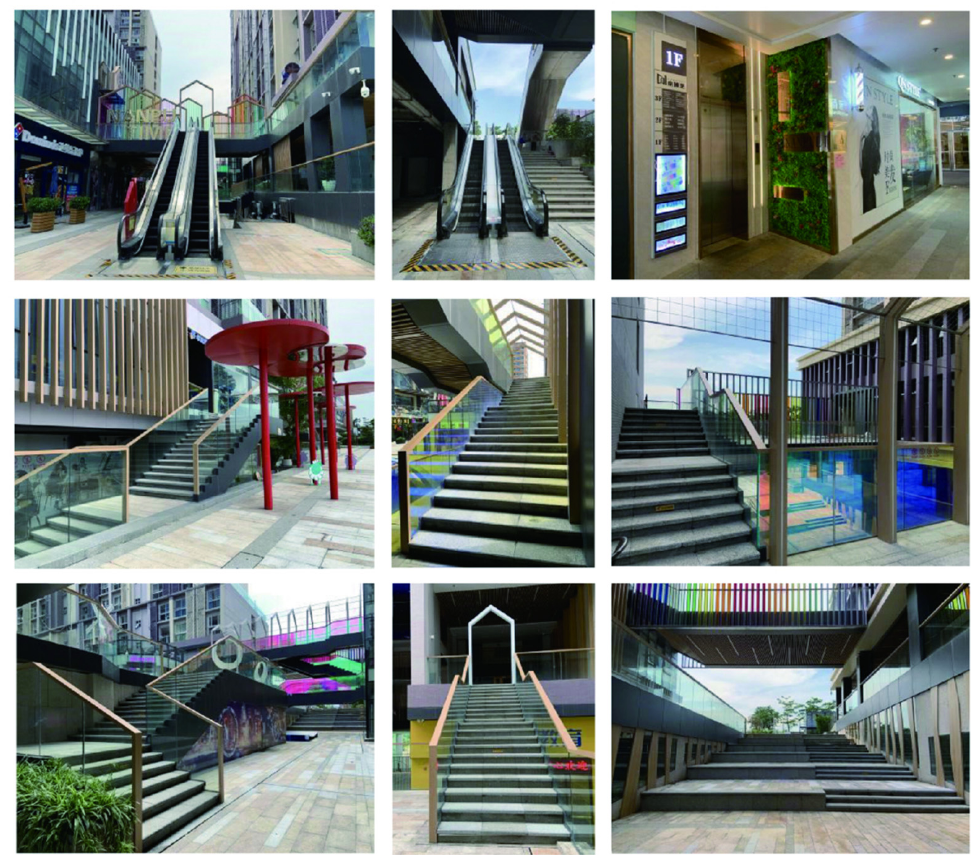
Figure 14. Current situation of stairs, escalators, and elevators of Nanpu Times.